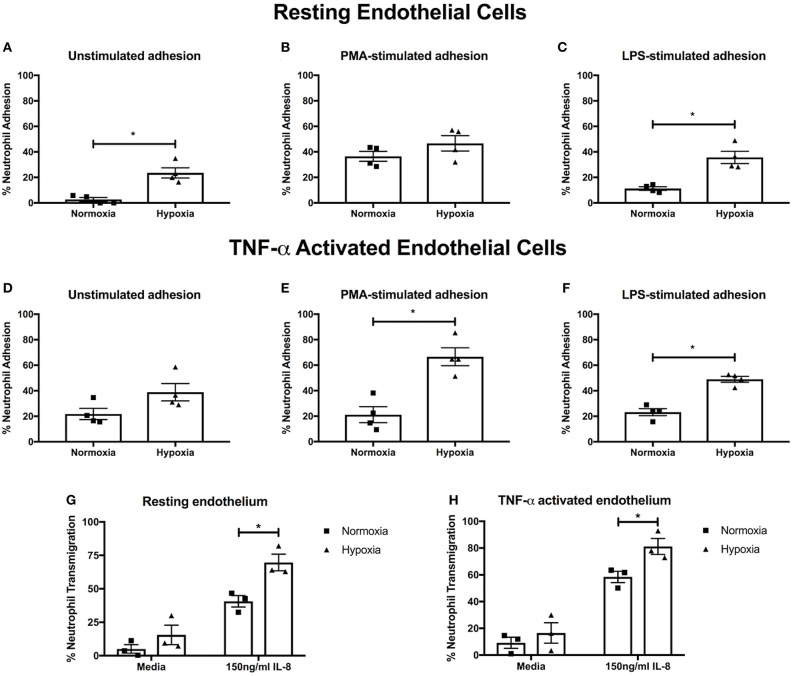
Hypoxia enhances neutrophil adhesion and trans-endothelial migration. BCECF-AM labeled neutrophil adhesion to endothelial monolayers over 30 min was assessed under normoxia (21% oxygen) and hypoxia (1% oxygen). We first examined neutrophil adhesion to resting HUVEC using (A) unstimulated neutrophils, (B) neutrophils stimulated with 20 nM PMA and (C) cells stimulated with 100 ng/ml LPS. Next, we examined the effects of hypoxia upon neutrophil adhesion to activated HUVEC, which had been stimulated with 10 ng/ml TNF-α for 24 h prior to experimentation. We evaluated (D) unstimulated neutrophil adhesion, (E) neutrophil adhesion in response to 20 nM PMA and (F) neutrophil adhesion in response to 100 ng/ml LPS. Finally, the effects of hypoxia upon trans-endothelial migration of CellTracker™ Green labeled neutrophils over 90 min was evaluated. Data are presented as the mean ± SEM from four independent experiments and analyzed by a Wilcoxon matched pairs test. (G) Neutrophil transmigration across resting endothelial monolayers was measured under both normoxia and hypoxia in the absence or presence of 150 ng/ml IL-8. (H) HUVEC were stimulated with 10 ng/ml TNF-α for 24 h. Neutrophil trans-endothelial migration was subsequently measured in the absence or presence of 150 ng/ml IL-8 under normoxic or hypoxic conditions. Data are presented as the mean ± SEM from three independent experiments and analyzed by two-way ANOVA with a Dunnett's multiple comparison test. * = p < 0.05. HIF, hypoxia-inducible factor; PMA, phorbol 12-myristate 13-acetate.